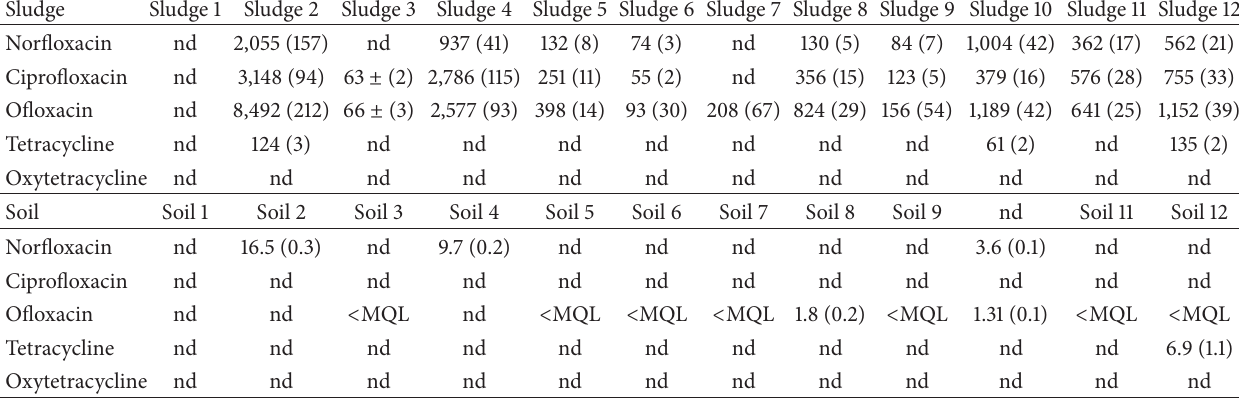
Table 4: Levels (ng/g dry matter) of target tetracyclines and fluoroquinolones measured in sludge and soil that received the corresponding